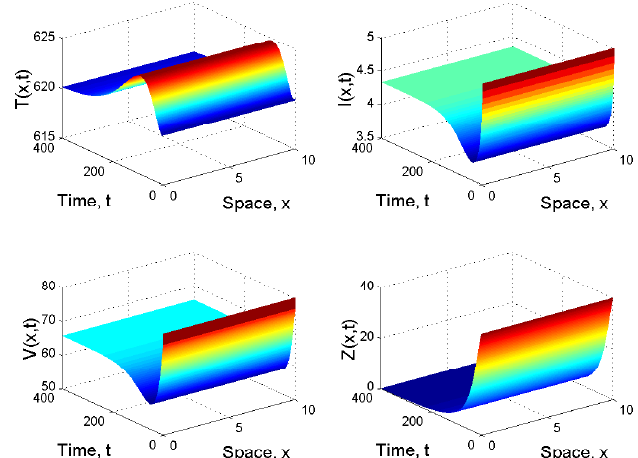
Figure 2. Spatiotemporal dynamics of the model (21) when R 0 = 2.0830 > 1 and R Z